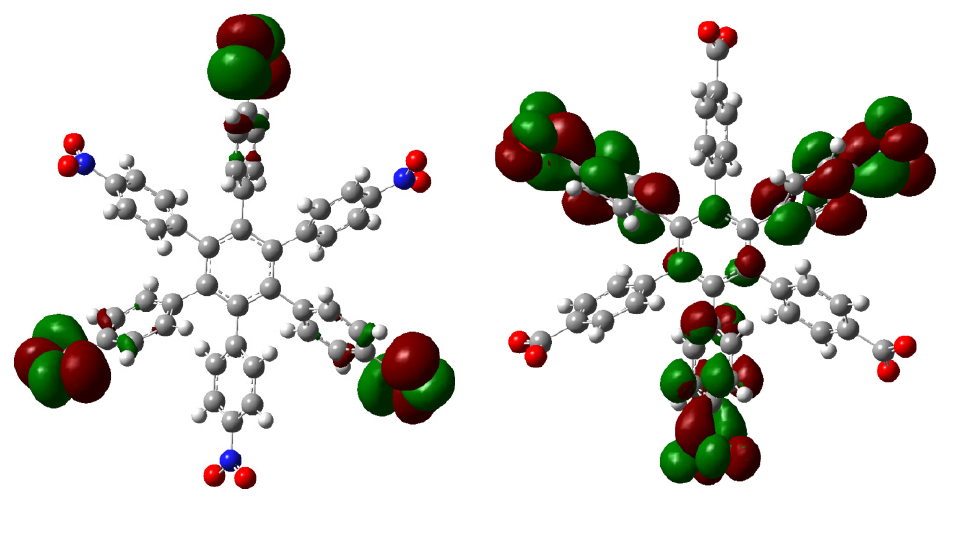
Figure 3. Frontier molecular orbitals of HAB1